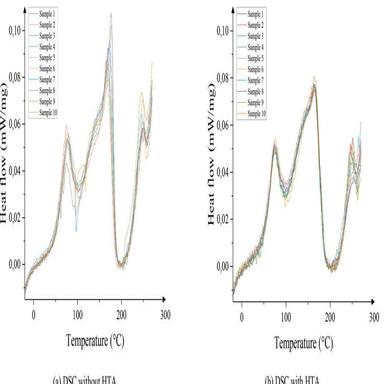
DSC results of TPU measurements considering a heating rate of 15 ◦C/min: DSC measurements (a) without and (b) with Kryonaut.